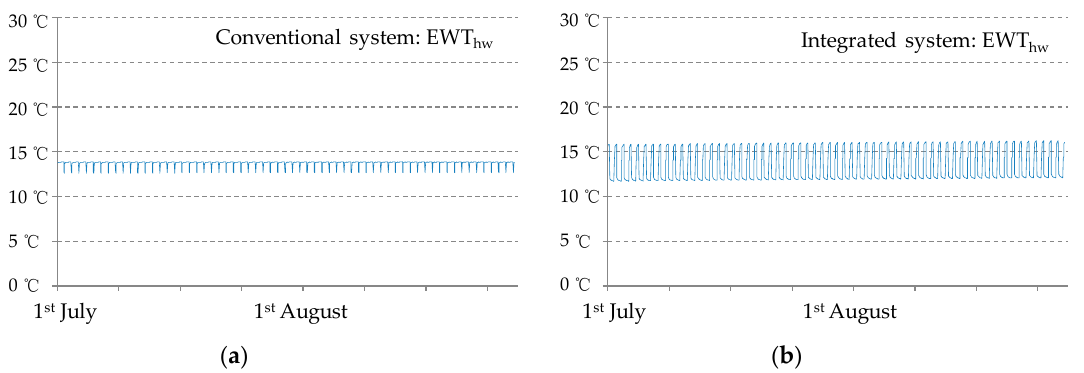
Figure 7. ( a ) EWT hw of the conventional geothermal system; ( b ) the integrated geothermal system in July and August.